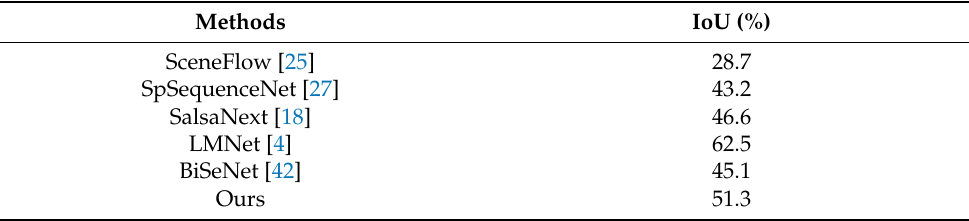
Table 1. MOS performance compared to the state-of-the-art on the SemanticKITTI test set.